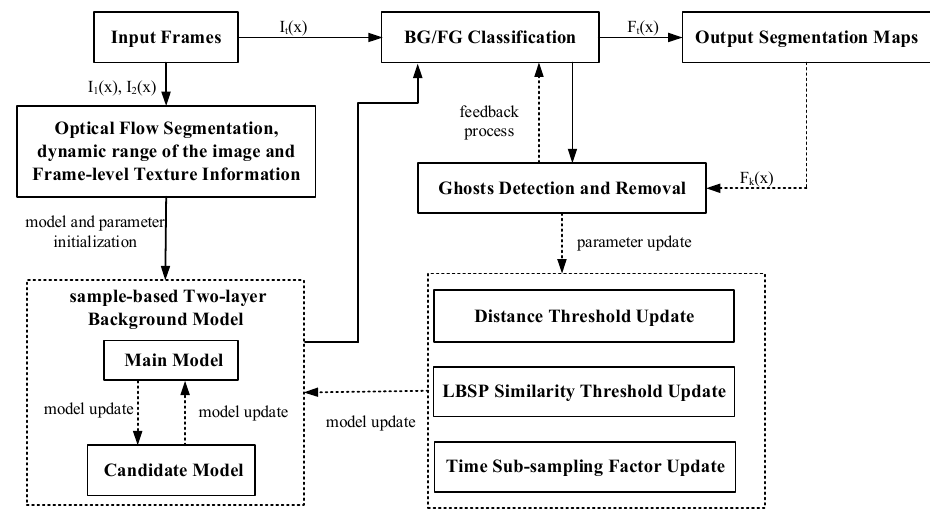
Figure 1. Block diagram of GhostDeReBS. The solid arrows indicate the processing flow of our systems for each frame; the dashed arrows indicate the update and feedback steps of our model.